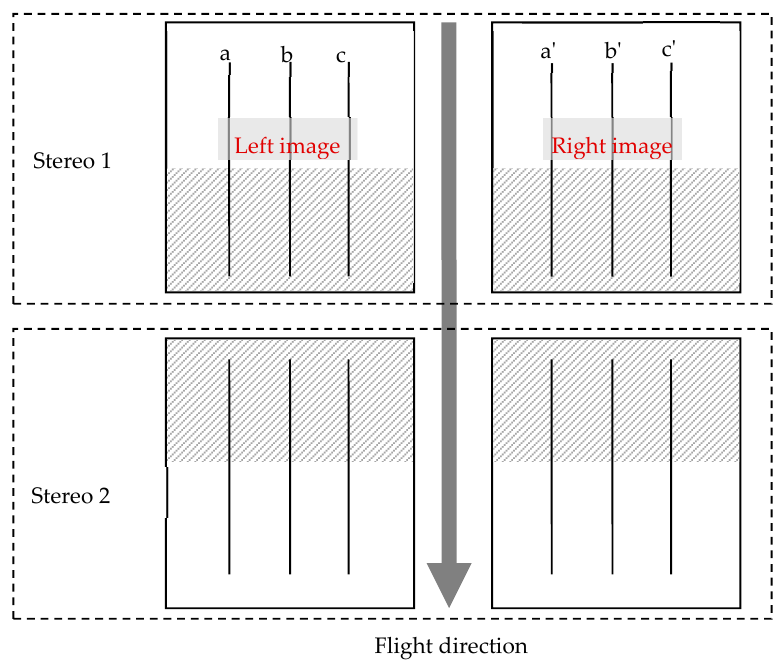
Figure 10. Illustration of the s election of corresponding power lines.